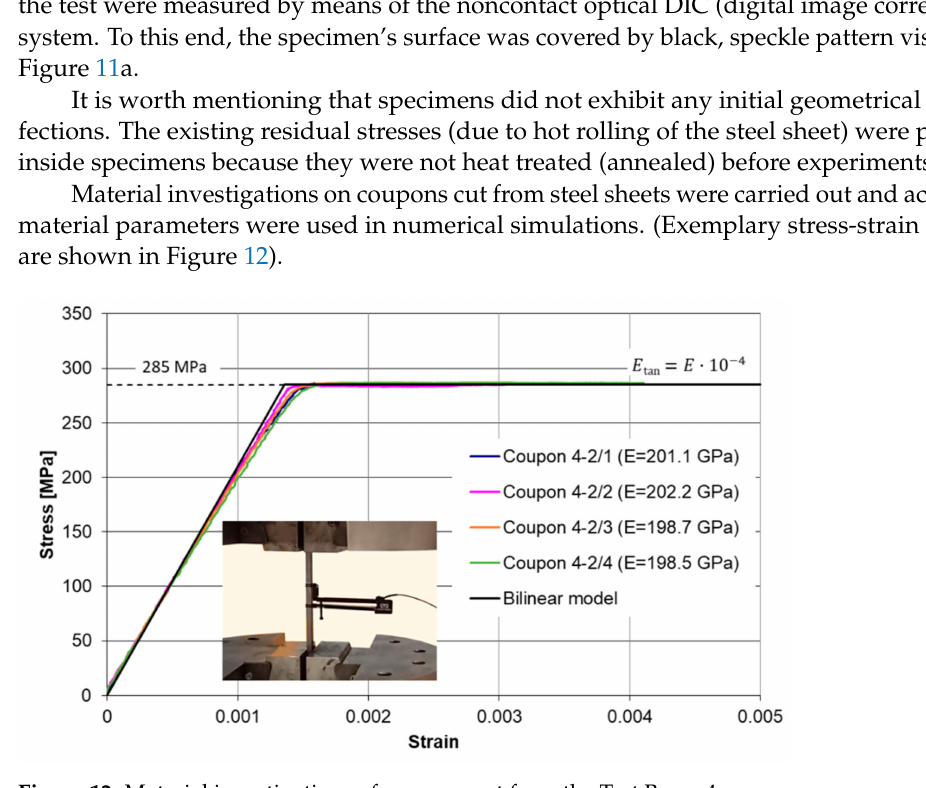
Figure 12. Material investigations of coupons cut from the Test Beam